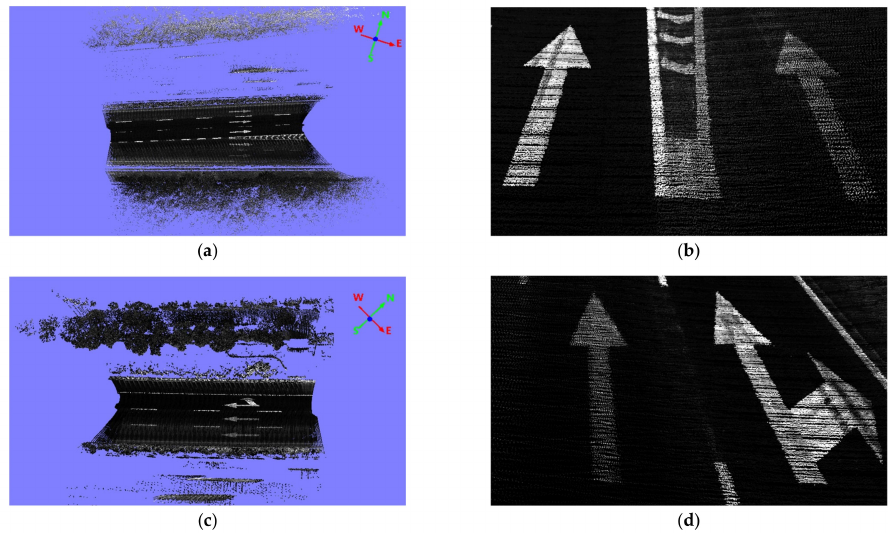
Figure 5. Overviews of the two datasets: ( a ) Dataset I rendered by the intensity attribute; ( b ) a detailed view of dataset I; ( c ) dataset II rendered by the intensity attribute; ( d ) a detailed view of dataset